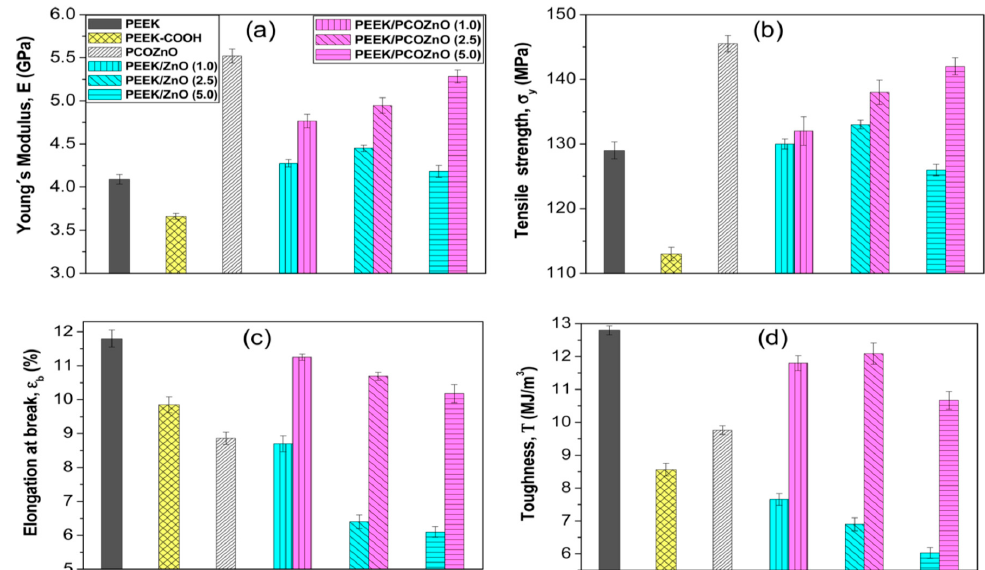
Figure 21. Tensile properties of PEEK/ZnO and modified PEEK/ZnO nanocomposites: ( a ) elastic modulus, ( b ) tensile strength, ( c ) strain at break, and ( d ) toughness. The values in parentheses of ( a ) indicate the weight percentage of ZnO. PCOZnO: PEEK − CO − O − CH2 − ZnO. Reproduced from [179] with permission of American Chemical Society.